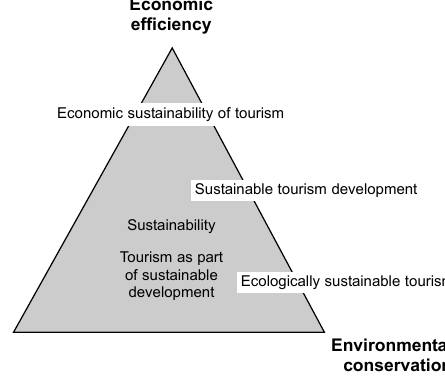
Fig. 2. Analysis of sustainable tourism (Adapted from Coccossis et al .